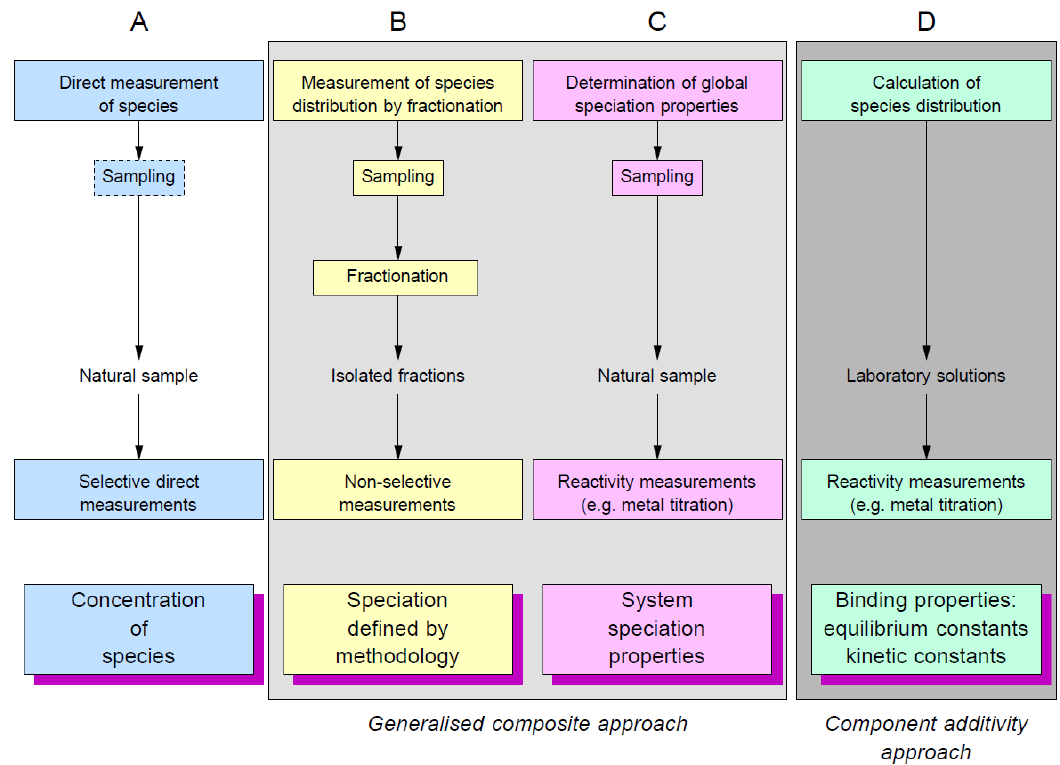
Figure 5. Schematic representation of different approaches used to study the speciation of trace elements in